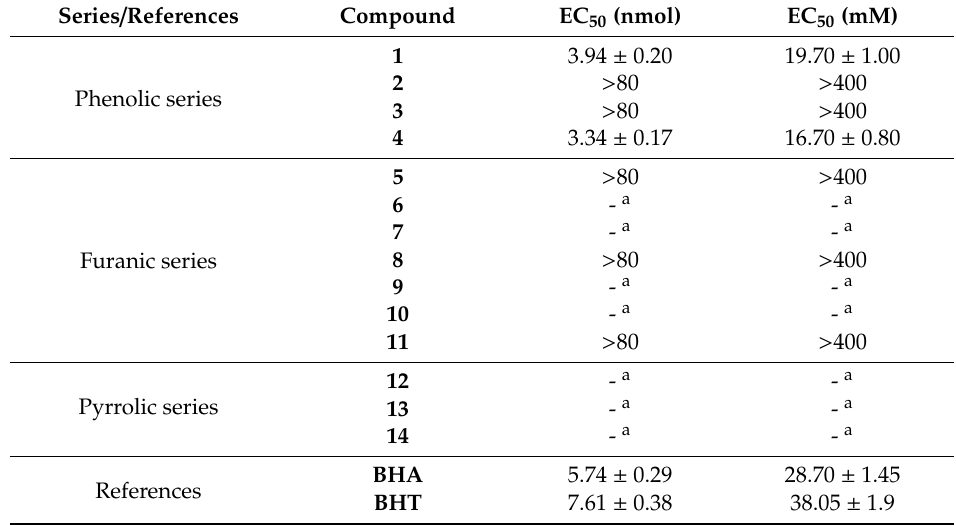
Table 1. EC 50 of synthesized molecules for DPPH (2,2-diphenyl-1-picrylhydrazyl) inhibition in